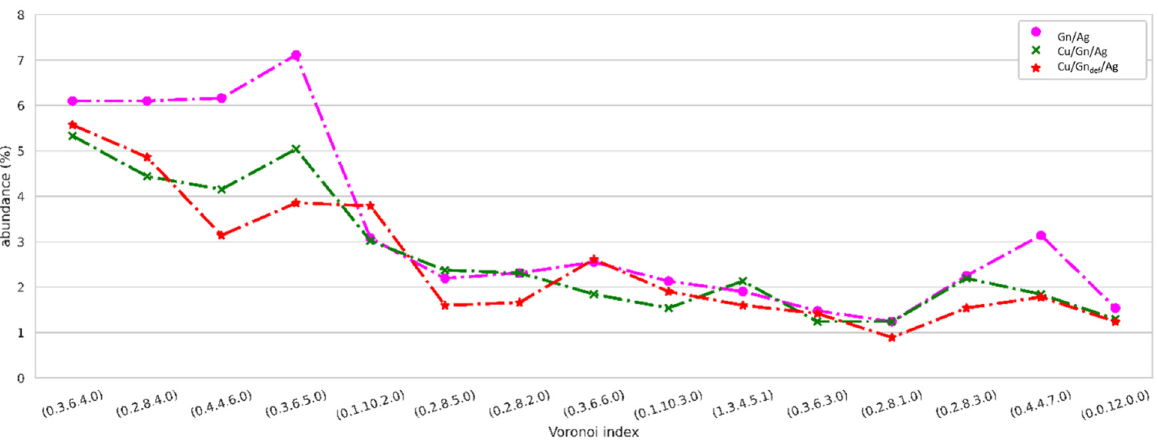
Figure 8. Abundance of 15 most representative VC topologies in liquid Ag droplet on Cu/Gn and Cu/Gn def substrates at 450 ps.